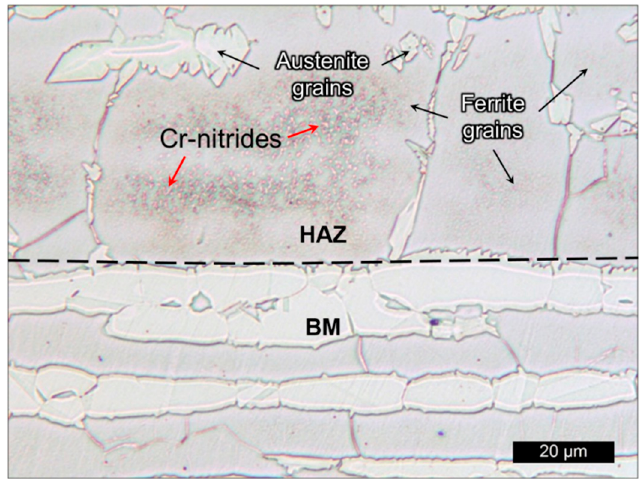
Figure 15. Cr nitrides in ferrite in HAZ. The dashed black line represents the boundary between the HAZ and the unaffected BM.